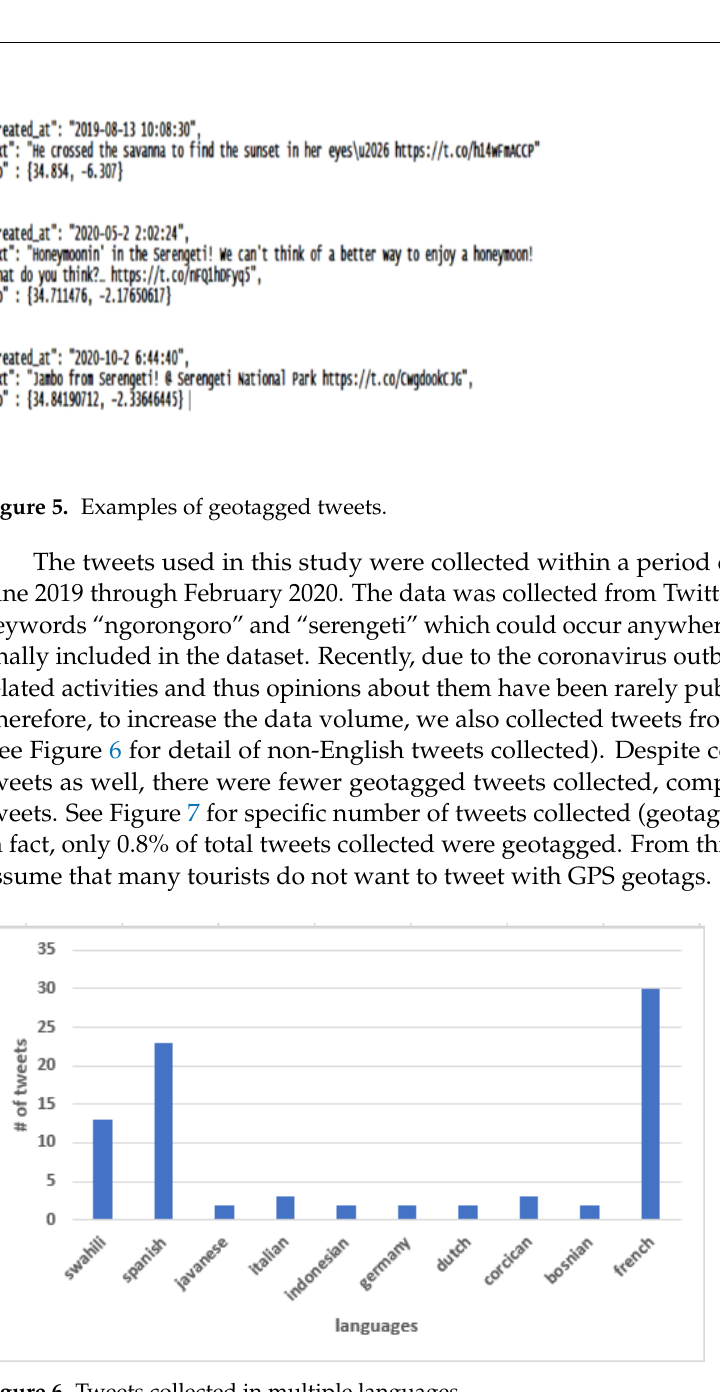
Figure 6. Tweets collected in multiple